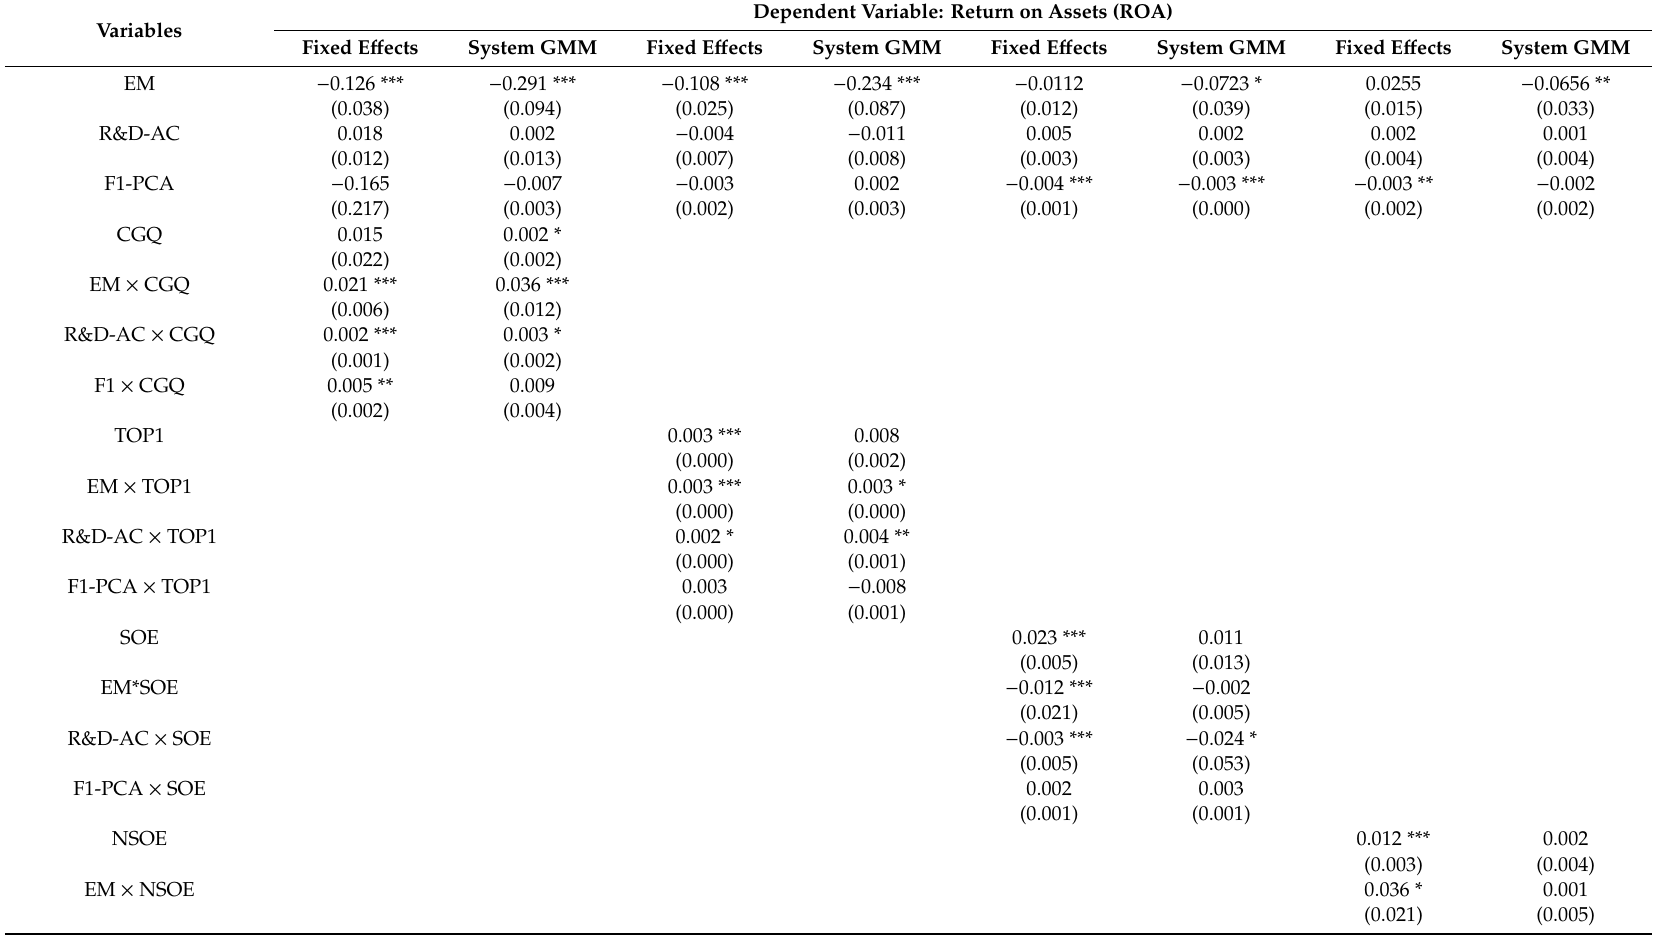
Table 10. Baseline models with alternative measure of agency